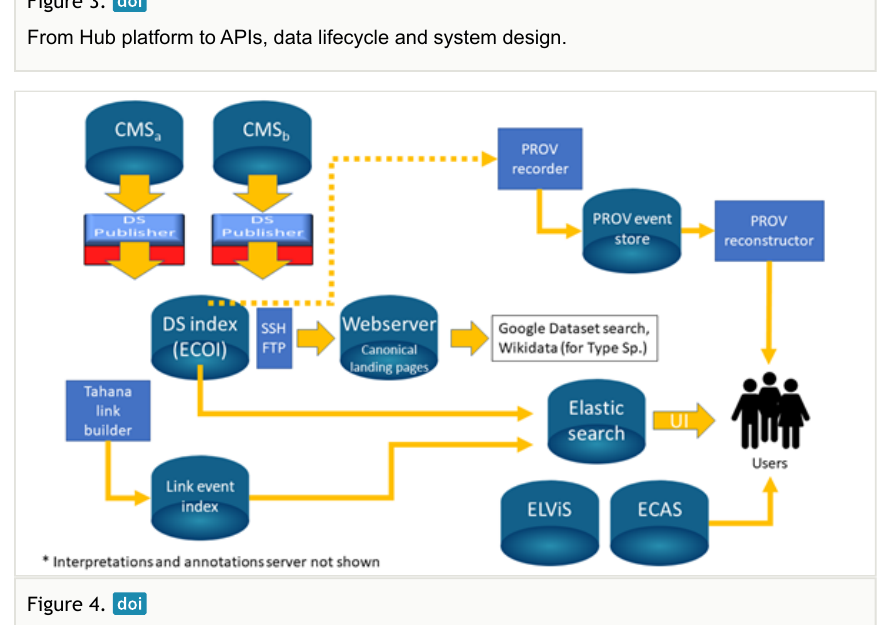
Figure 4. Illustrative system design based on multiple CORDRA object repository Enrichment of Digital Specimens either/both at time of creation or/and later is made possible by the algorithms of the ‘Tahana link builder’, a software component that finds and exposes the third-party data associated with natural science specimens to build the DiSSCo knowledge graph. Services such as ECOI Elasticsearch make it possible to query and find data of interest across multiple object types/repositories. Each Digital Specimen will have its own human-readable Web ‘landing’ page, as well as being both machine-